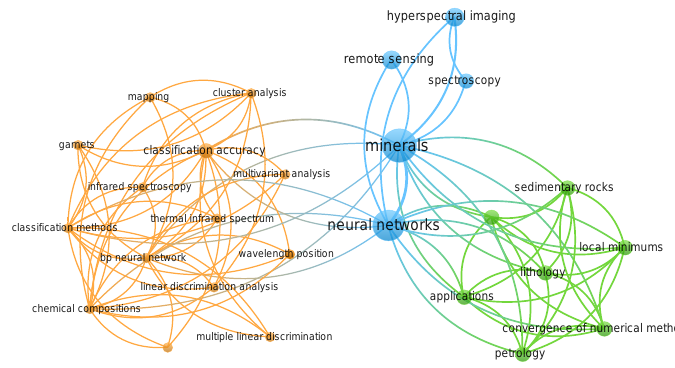
Figure 5. Keyword detection of artificial-neural-network-based